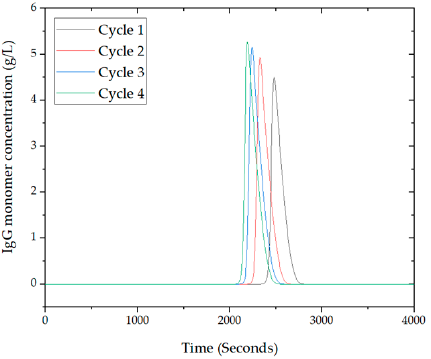
Figure 15. IEX chromatograms of iCCC start ‐ up.